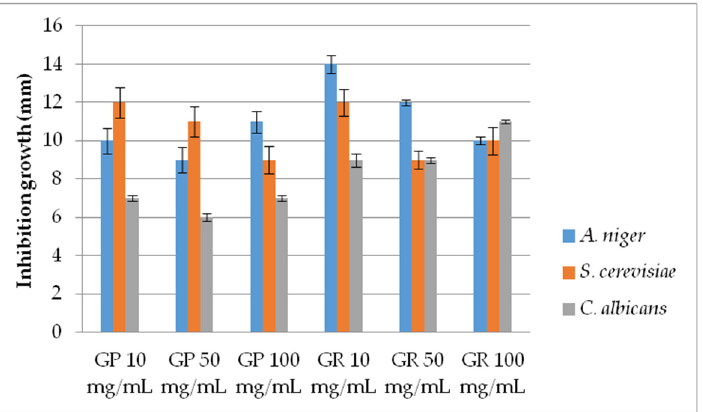
Figure 1. Antifungal activity of G. pfeifferi and G. resinaceum EtOH extracts using disk-diffusion method. Abbreviations: GP— G. pfeifferi ; GR— G. resinaceum .